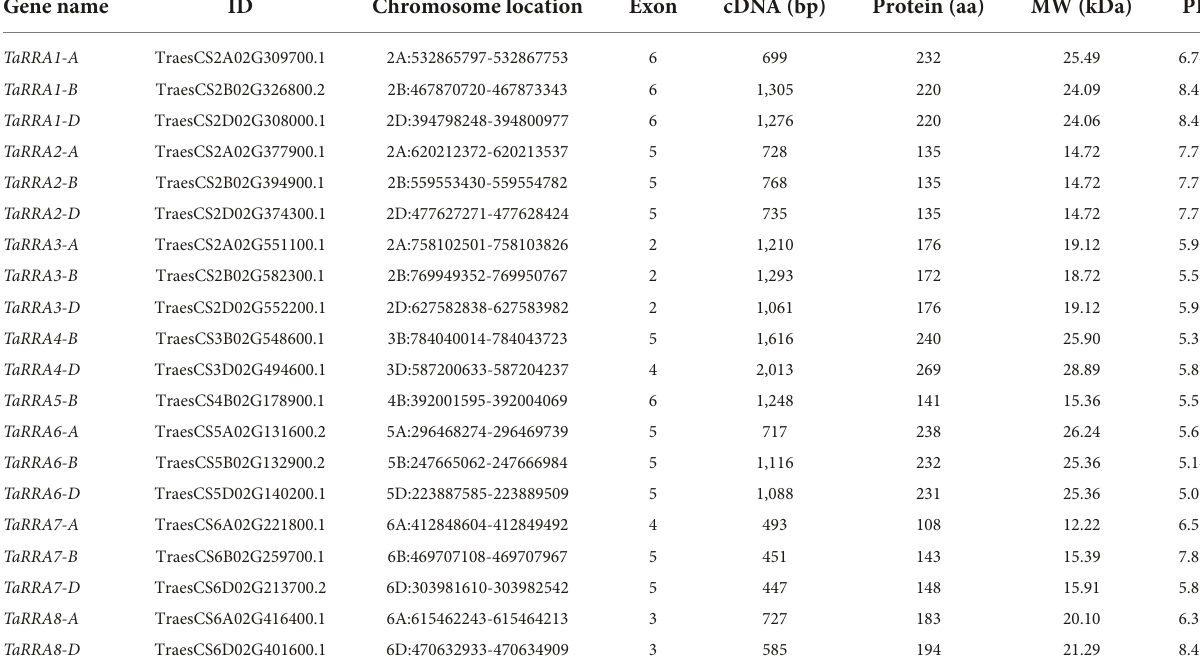
TABLE 2 Information of the TaRRA gene members in